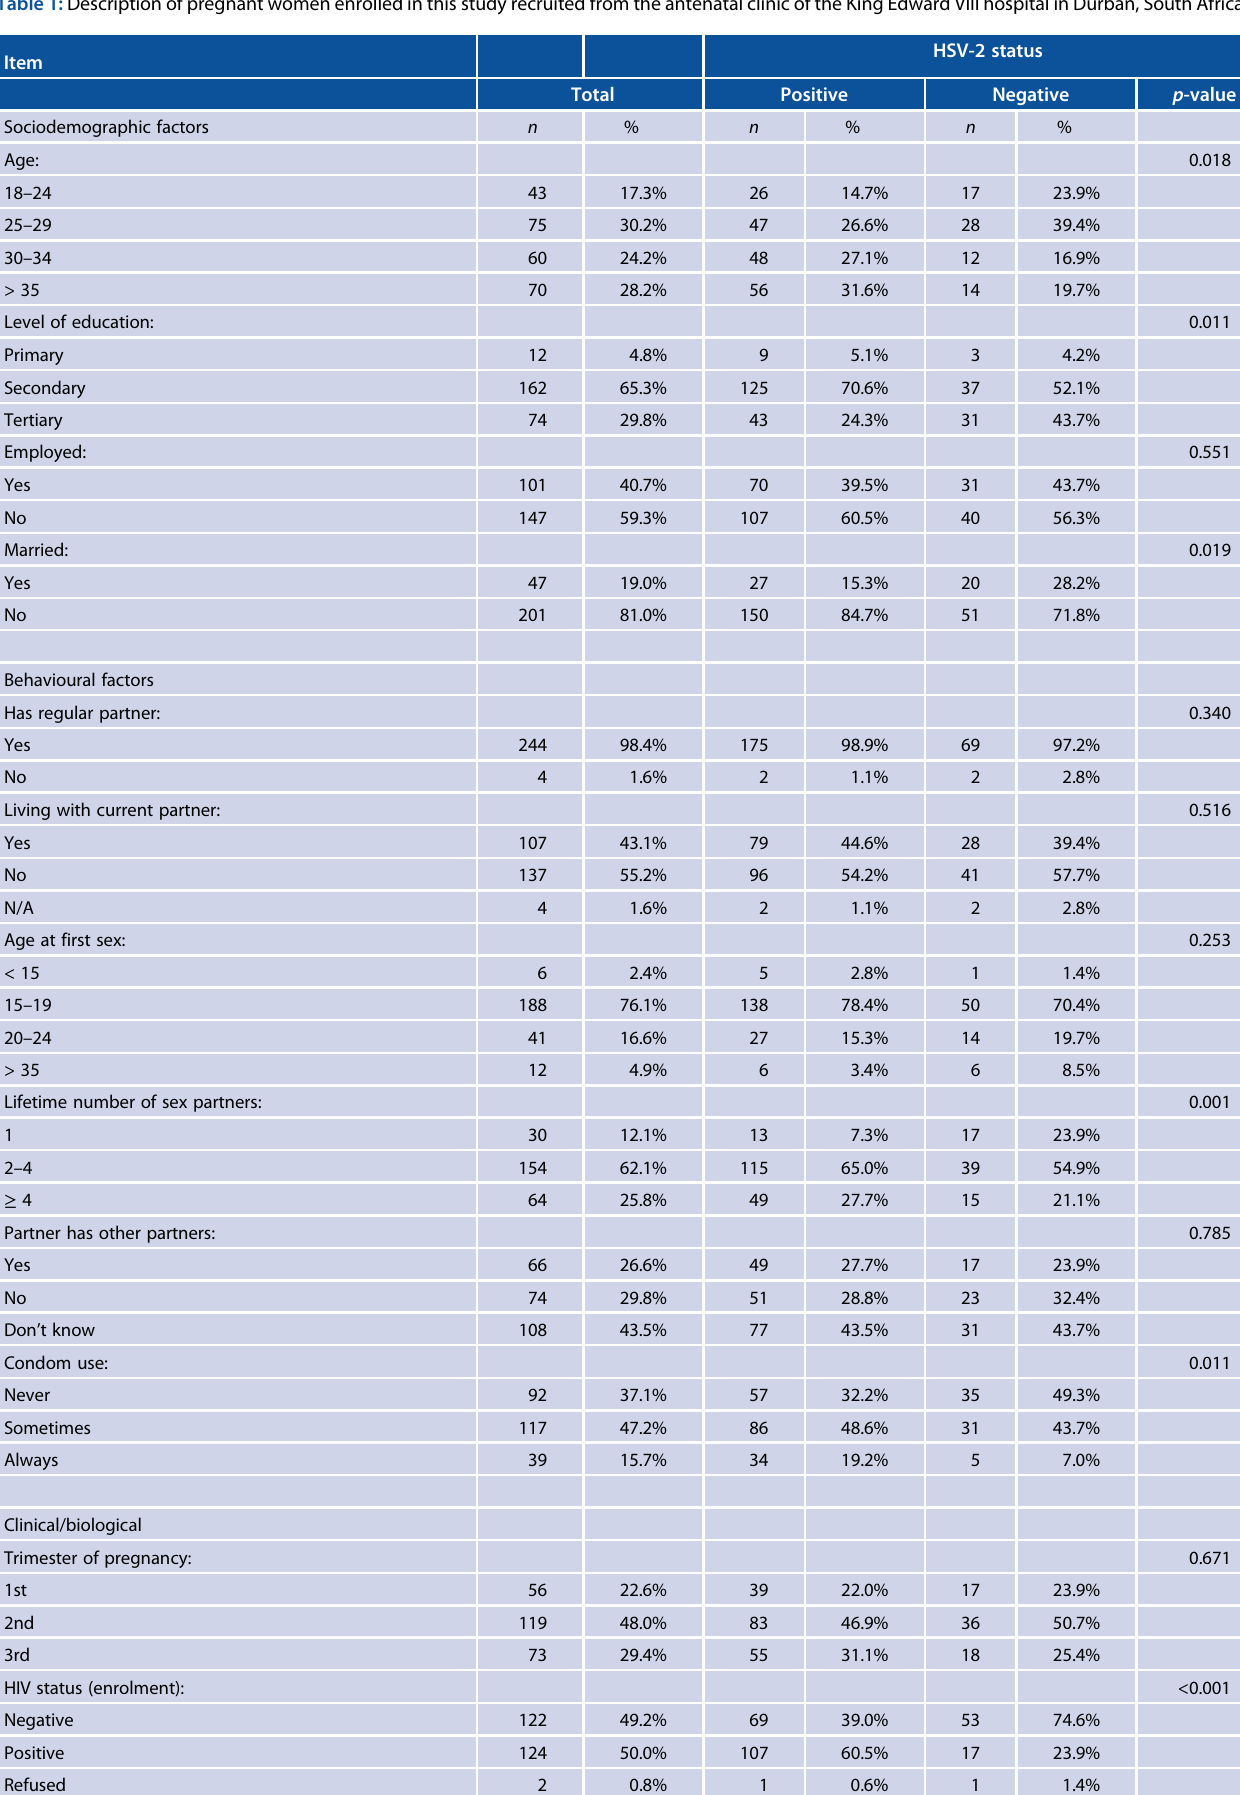
Table 1: Description of pregnant women enrolled in this study recruited from the antenatal clinic of the King Edward VIII hospital in Durban, South Africa Item Sociodemographic